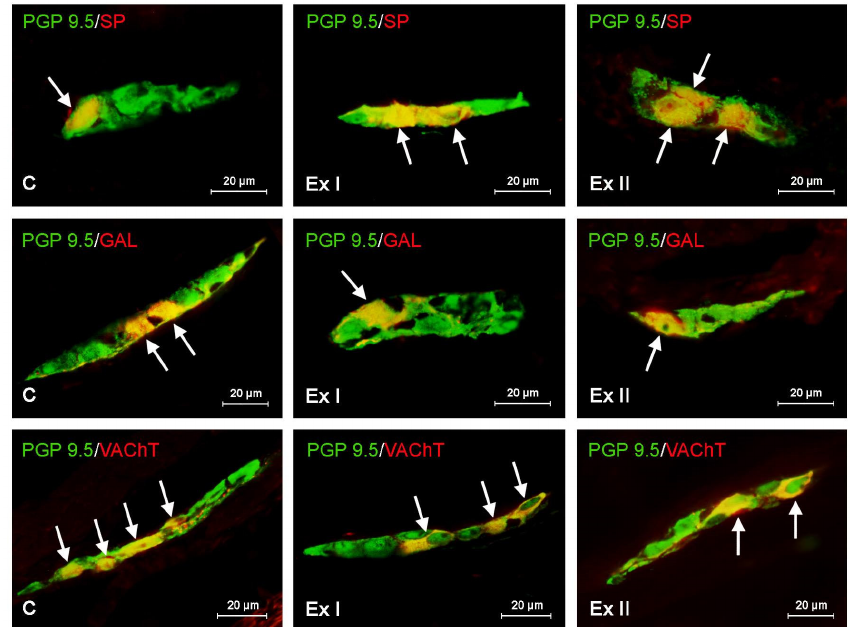
Figure 3. Distribution of neurons immunopositive to panneuronal marker-protein gene-product 9.5 (PGP 9.5) and other neuronal active substances—substance P (SP), galanin (GAL), or vesicular acetylcholine transporter (VAChT) in the submucous ganglia of porcine stomach in physiological conditions (C) and after administration of small dose (Ex I) and high dose (Ex II) of bisphenol A. The pictures are the result of the overlap of both stainings. The arrows indicate cells immunopositive for both PGP 9.5 and the other neuronal active substance